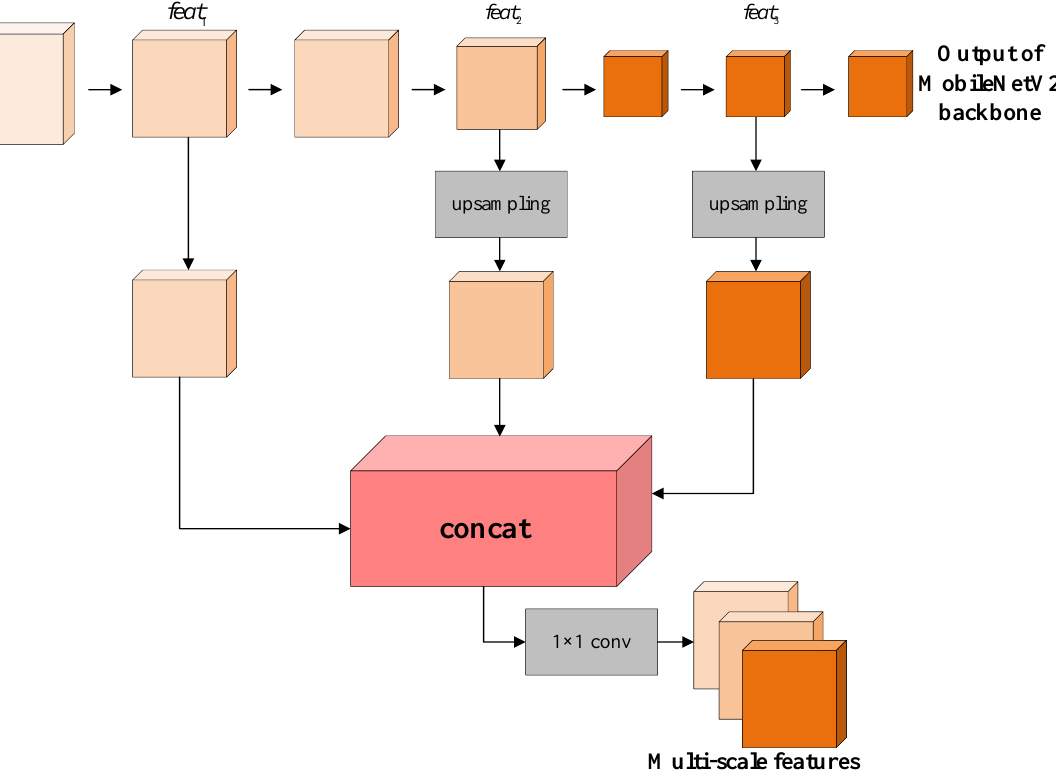
Figure 8. The schematic diagram of multi-scale feature fusion